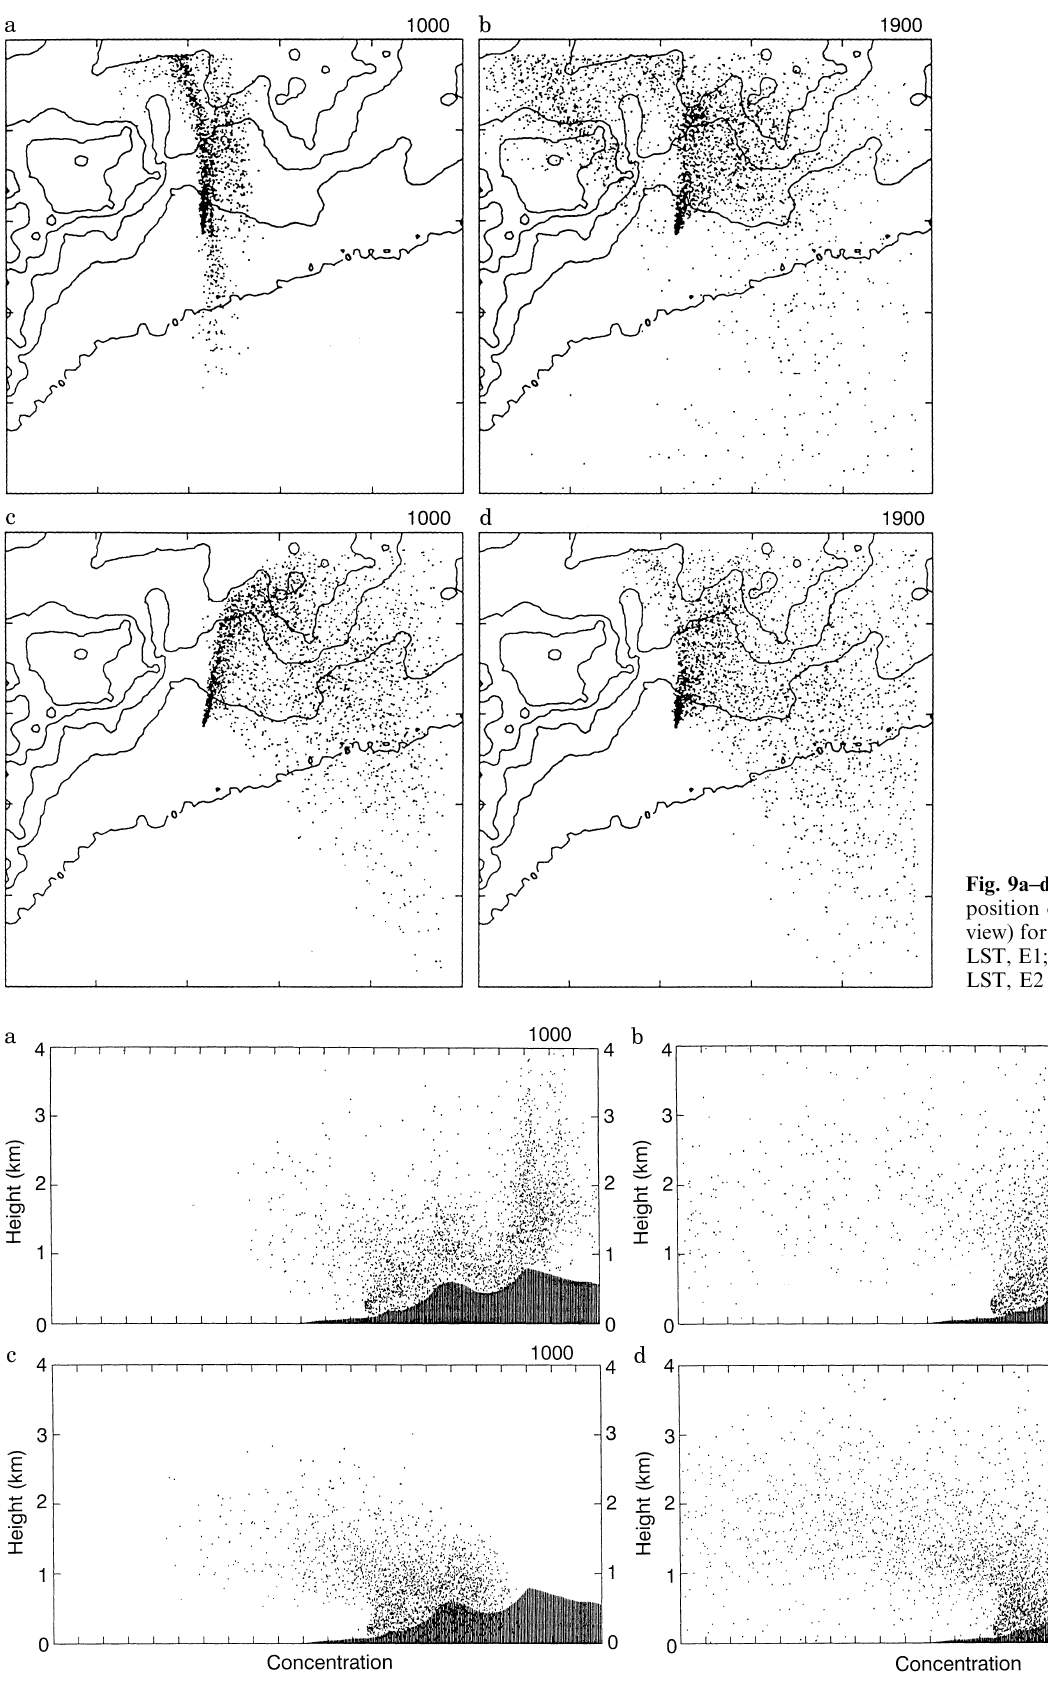
Fig. 10a–d. Integrated particle position distribution (lateral view) for a 1000 LST, E1; b 1900 LST, E1; c 1000 LST, E2; d 1900 LST,